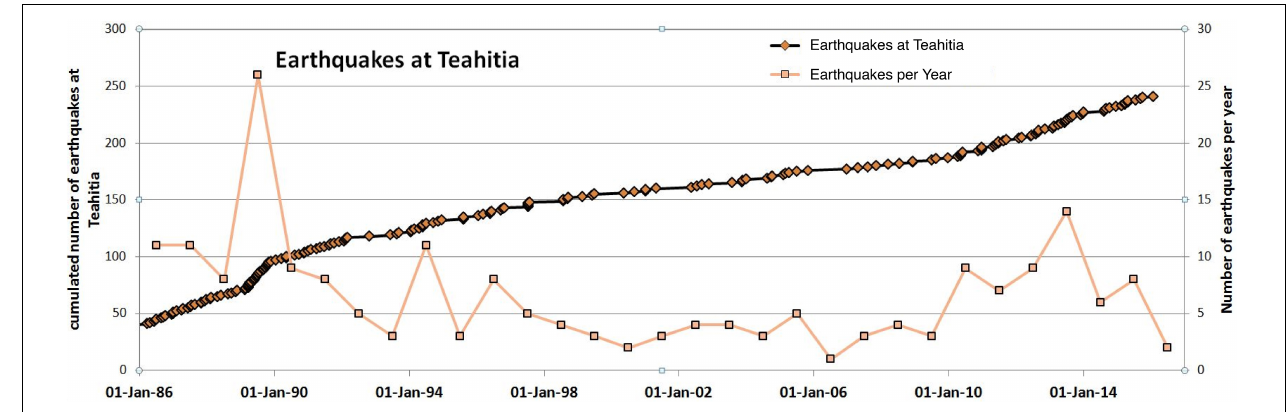
FIGURE 6 | Time series plot for cumulative number of seismic earthquake events detected at Teahitia Seamount via the Réseau Sismique Polynésie (Polynesian Seismic Network), 1986–2019, and the frequency (events per year) of those earthquakes over the same